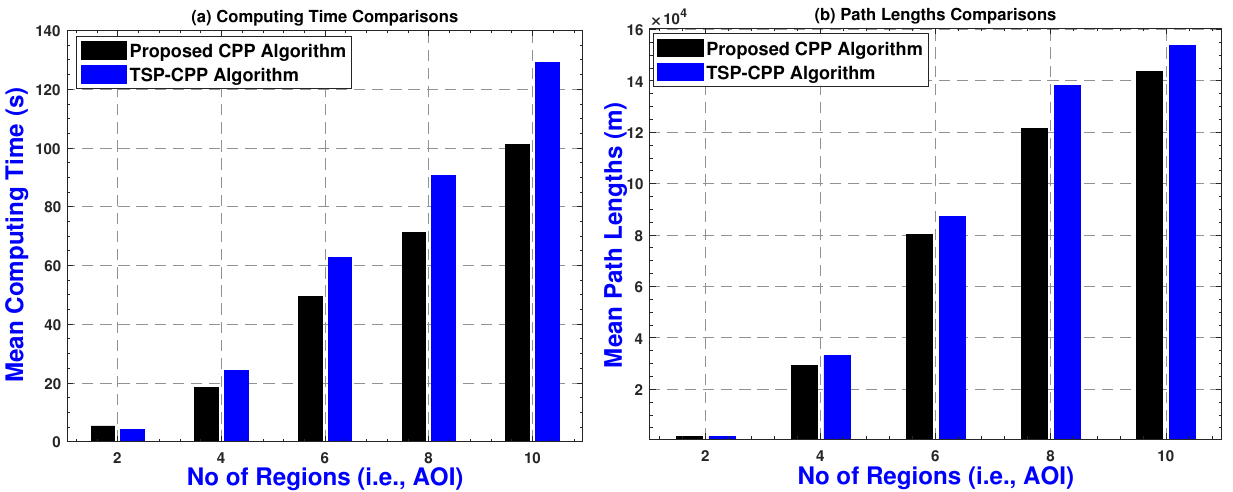
Figure 18. ( a ): Computing Time: Proposed algorithm vs. TSP-CPP. ( b ): Path Lengths: Proposed algorithm vs.